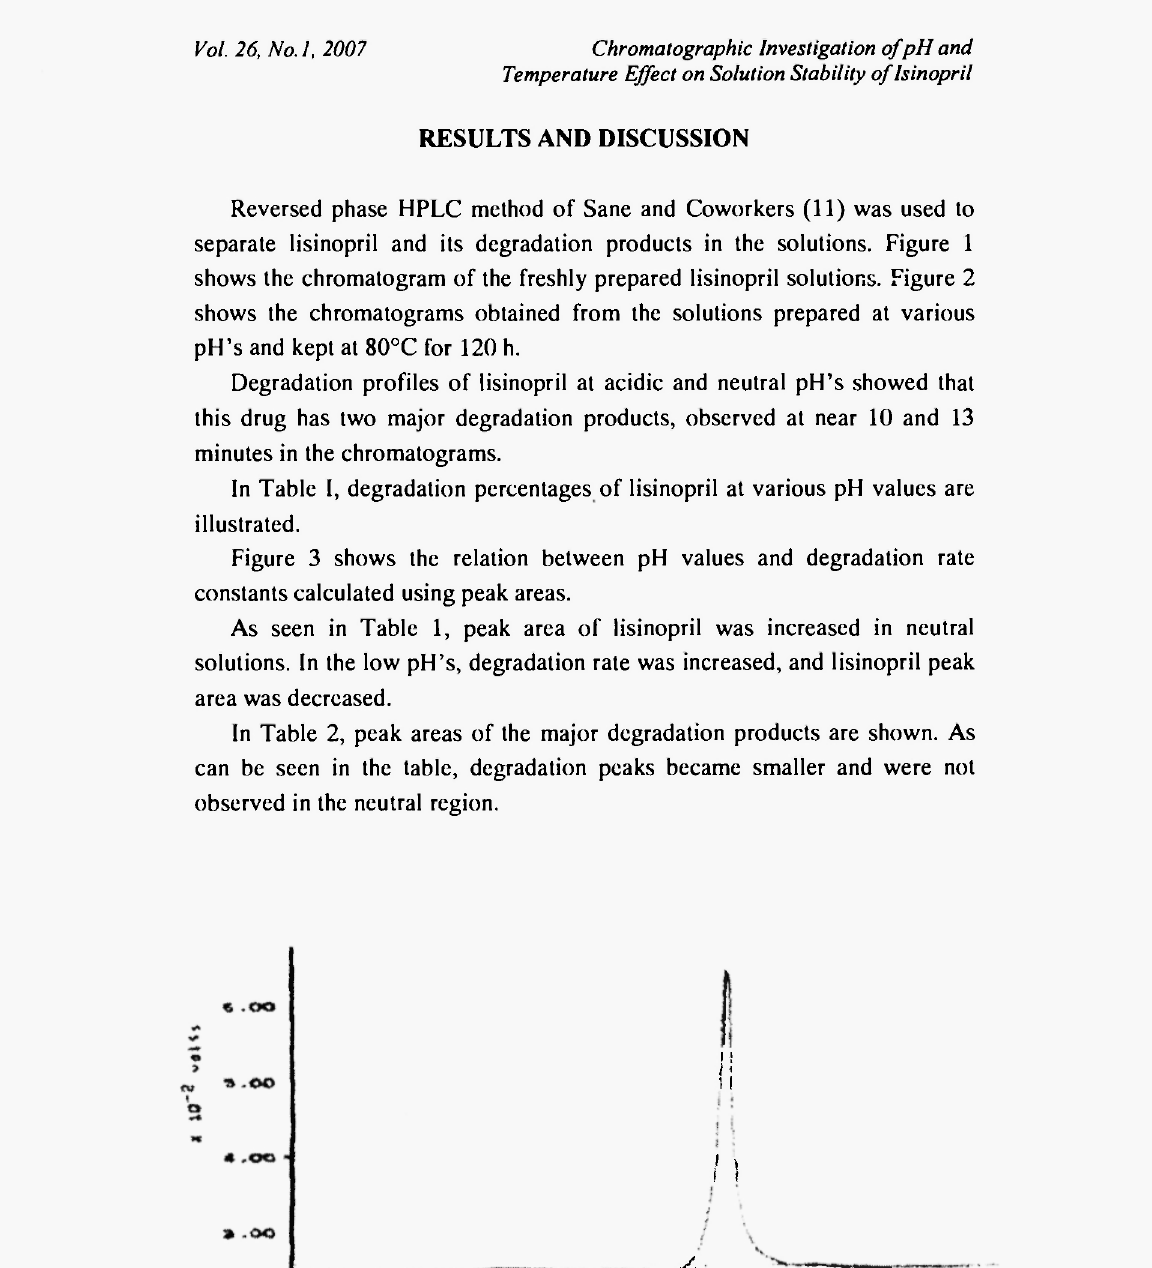
Fig. 1: HPLC Chromatogram of Freshly Prepared Lisinopril Solution in Water (Cons:75 Mgml/ 1